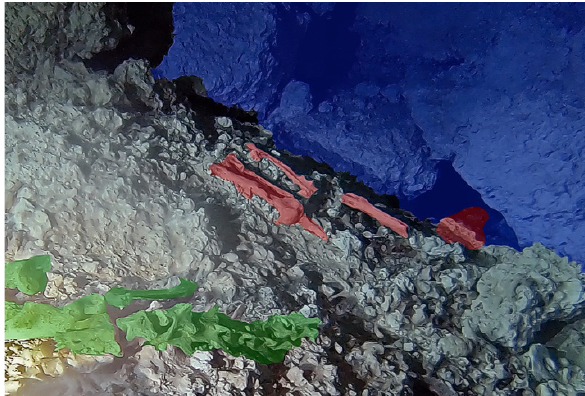
Figure 5 . While some bones are easily accessible for photogrammetry (highlighted in green), others (highlighted in red) are located under an overhanging rock (highlighted in blue), and cannot be documented using standard photogrammetric setups